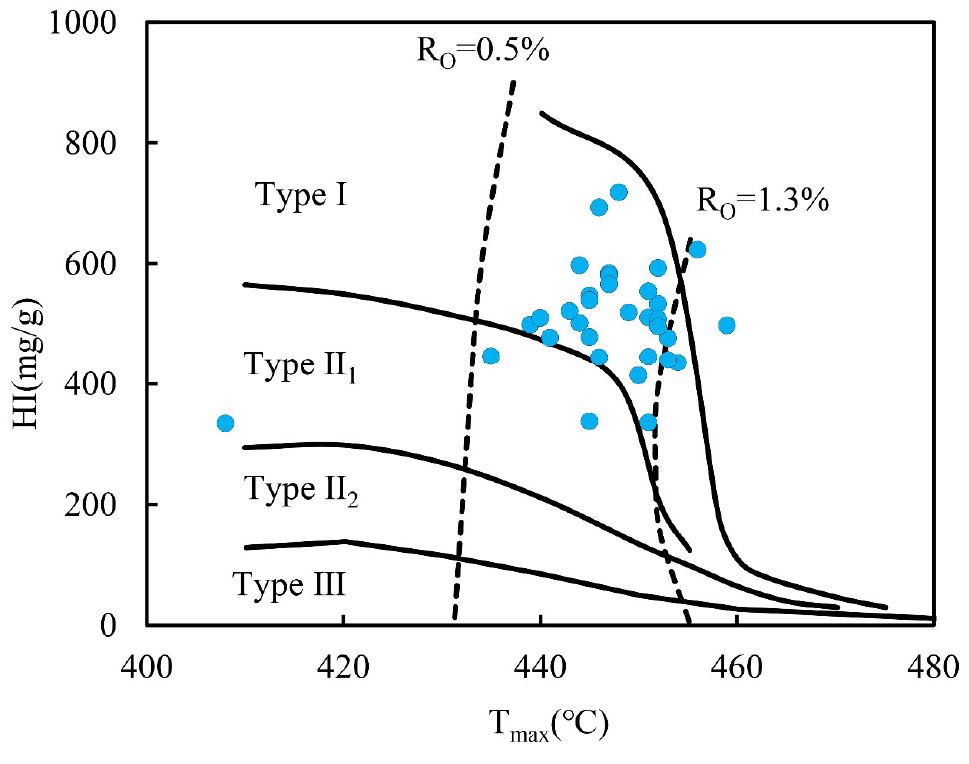
Figure 5. Diagram of HI vs. T max , indicating types I and II 1 organic matter of the Qingshankou lacustrine shales.